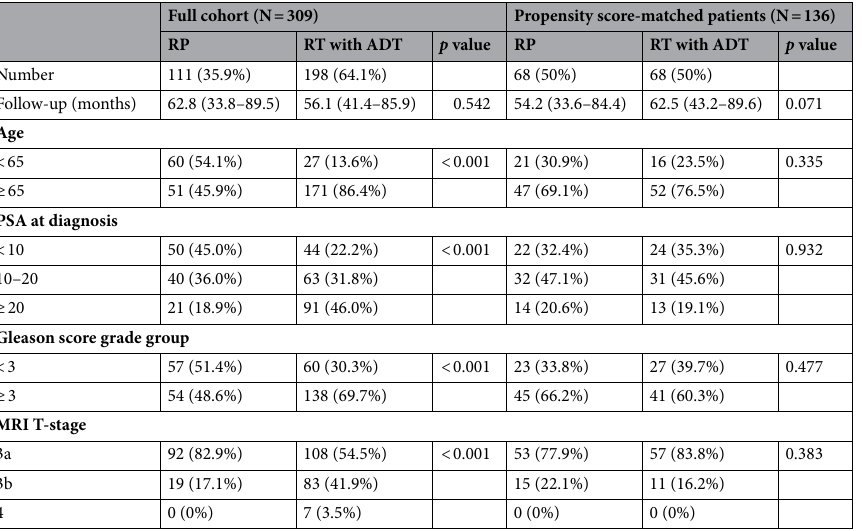
Table 1. Baseline characteristics of patients. The Mann–Whitney U-test was performed to determine statistical significance for continuous variables between the RP and the RT group while chi-square test or Fisher’s exact test was used for categorical variables. To reduce selection bias, we performed propensity score (PS) matching at a 1:1 ratio of the following variables: age at diagnosis, biopsy GS grade group, PSA at diagnosis and clinical T stage. Two-sided p values were calculated and a level of < 0.05 was considered statistically significant. RP radical prostatectomy, RT radiotherapy, ADT androgen deprivation